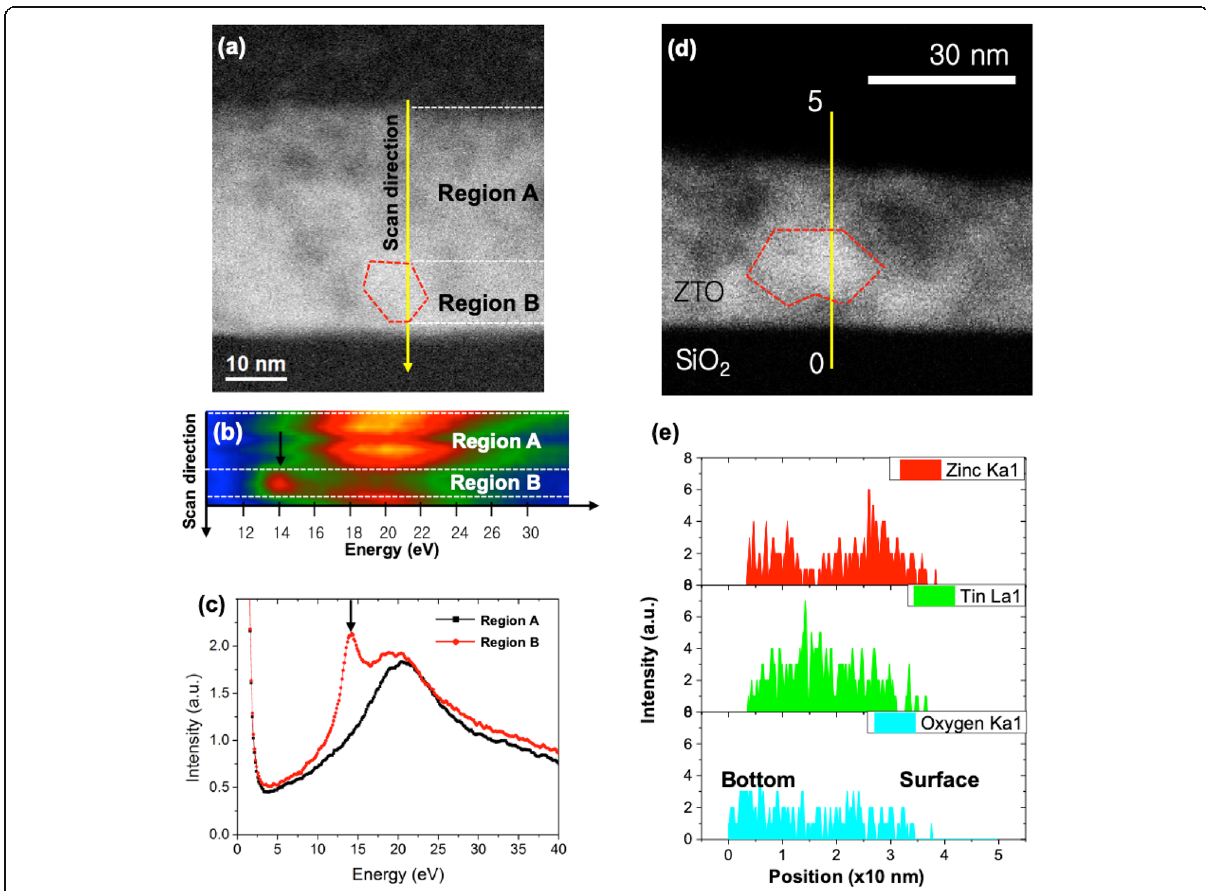
Fig. 6 a STEM image of the ZTO thin films on SiO 2 /Si substrate after excimer laser irradiation. b Low-loss EEL spectrum image across the ZTO thin film along the line scan in a . The ZTO film is composed of two distinctive regions: upper (region A) and lower (region B) region. The region B contains additional plasmon peak at ~ 14 eV. c Low-loss spectrum from region A and region B, respectively. d STEM image of ZTO thin films where EDS line scan was performed. e EDS results: Zn, Sn, and oxygen profiles along the line scan drawn in